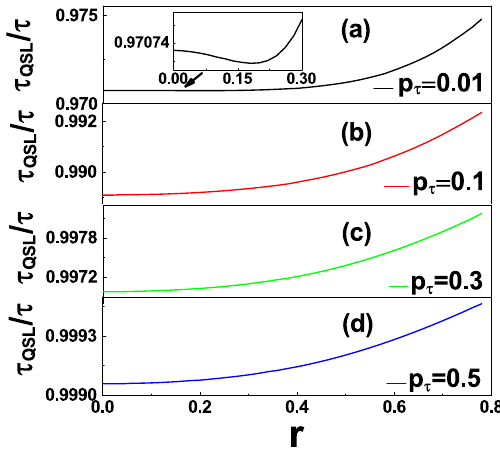
Fig. 2 QSLT for a given two-qubit state, quantified by τ QSL /τ as a function of the acceleration parameter r , when only Bob’s state is in the ADC. We set q R =